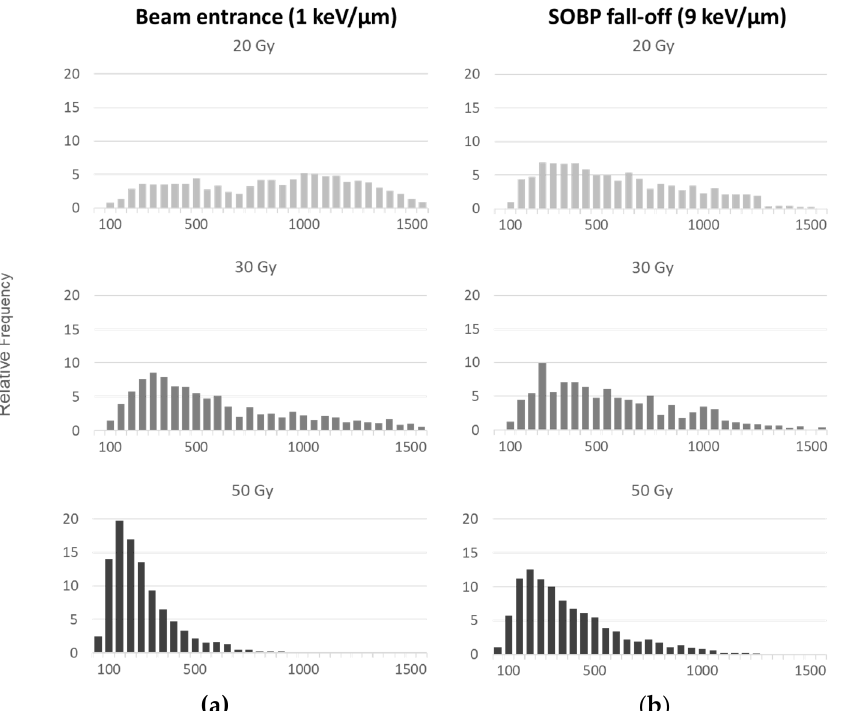
Figure 7. Relative frequency distributions of apparent molecule lengths measured using AFM for plasmid pBR322 irradiated with doses of 20, 30 and 50 Gy at ( a ) the entrance of proton beam (LET = 1 keV/ μ m) and ( b ) SOBP fall-off (LET = 9 keV/ μ m).